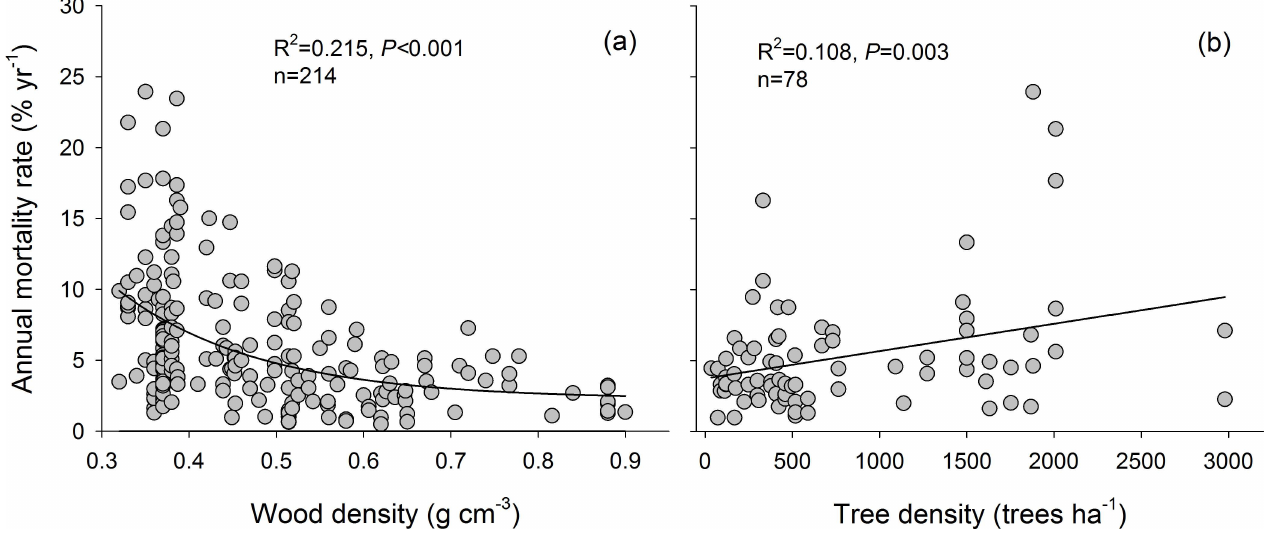
Fig 2. Relationships betweenannualmortality rate and (a) wood density and (b) tree density.